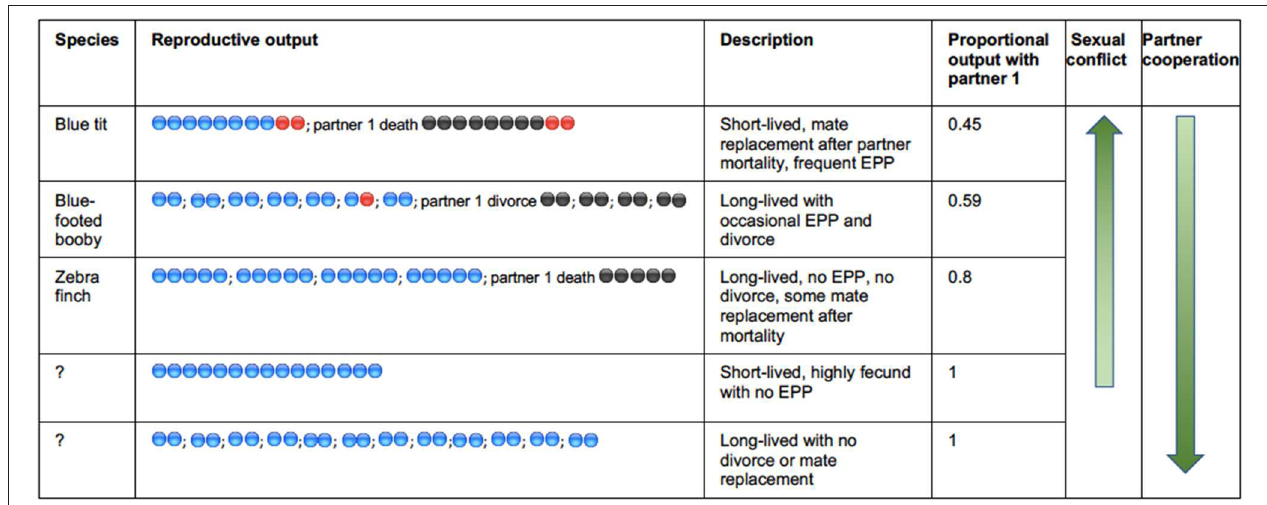
FIGURE 1 | Illustrating the key drivers of sexual conflict in socially monogamous birds. Reproductive attempts are separated by “;” with eggs produced with a first partner shaded in blue, subsequent partner shaded in black, and extrapair paternity represented with red shading. Sequential monogamy can be driven by the replacement of a mate that dies, or divorce. The three species exemplified are based on approximate levels of EPP, clutch sizes, annual mortality, and divorce. There are no clear avian examples of the two hypothetical situations indicated at the bottom in which there would be lifetime